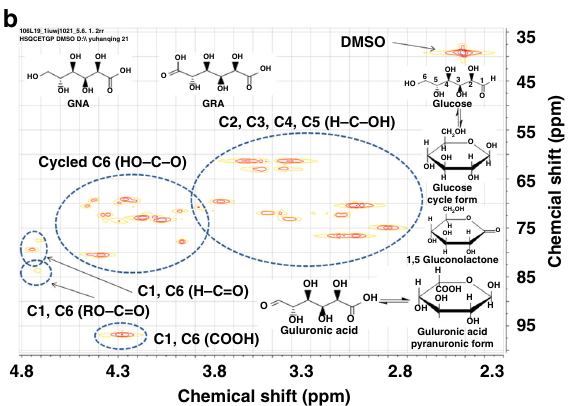
Guluronic acid pyranuronic form